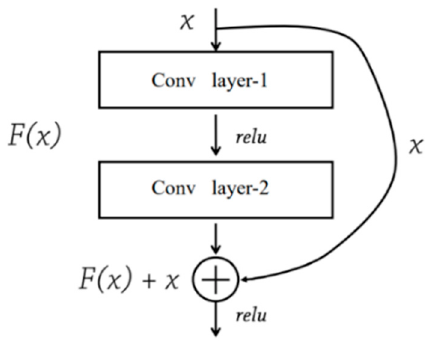
Figure 4. A residual block (derived from [41]).